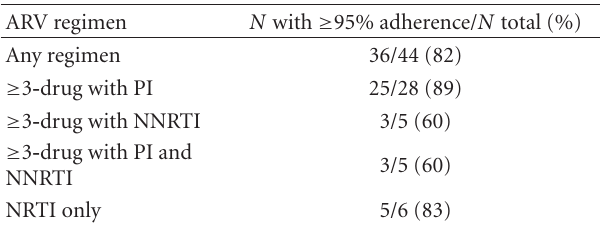
Table 2: Adherence to the last ARV regimen used during